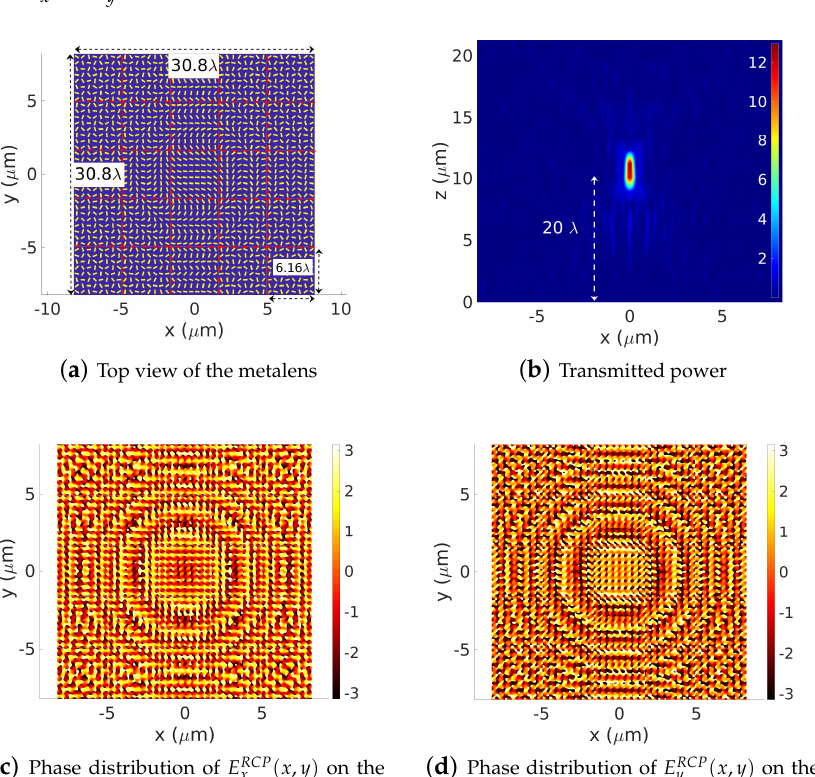
Figure 12. Forward simulation of a Ω = 30.8 λ × 30.8 λ -width Pachatarnam–Berry phase-based metalens. The lens is designed to have a focus length of f = 20 λ . Power distributions of the focusing spot in the ( x , y = 0, z ) plane. Phase distribution of E x ( x , y ) component of the cross-polarization (RCP) on the top of the PB-based metalens. The number sub-cells and truncation orders are set to 5 × 5 and m x = m y = 10, respectively. Numerical parameters: λ = 0.532 µ m, focus length z s = 20 λ , h = 400